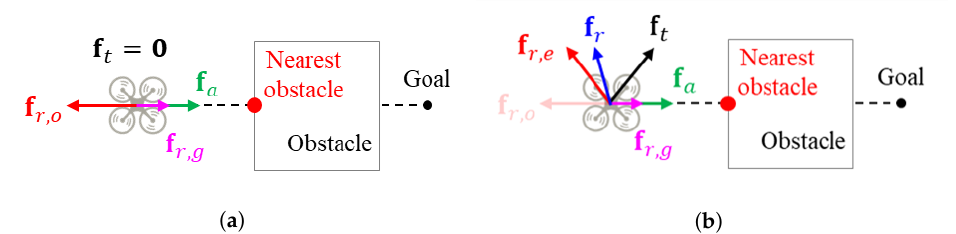
Figure 2. Comparison of the directions of each potential field between ( a ) conventional APF and ( b ) proposed